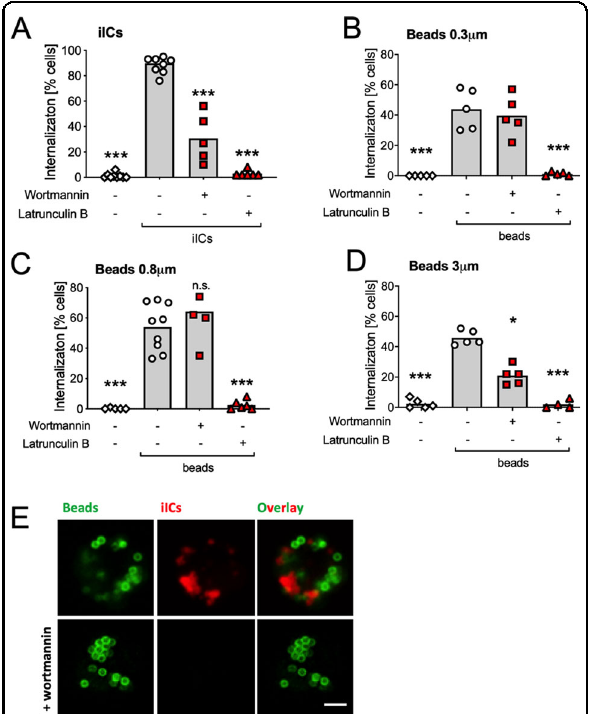
Fig. 4 Internalization of iICs and beads is controlled by distinct pathways. Neutrophils were incubated with small molecule inhibitors or vehicle at 37 °C for 10 min as indicated to inhibit PI3Ks and actin polymerization, respectively, and stimulated by mixing with A 2 μ g/ml iICs, B – D 5 IgG-opsonized beads/neutrophil of the indicated size or E a mixture of the iIC and 0.8 μ m beads for a further 30 min. Neutrophils were then allowed to adhere to electrostatically charged glass slides on ice and fi xed. Internalized and external iICs were labelled as detailed in ‘ Materials and methods ’ . A – D The percentage of cells that had internalized particles was counted and plotted. Each symbol represents the average value obtained in a separate experiment. Raw data were analyzed by one-way ANOVA and multiple comparison post-hoc test; *** p < 0.001; * p < 0.05. E Representative confocal images taken with a Leica SP8 with 63× oil immersion objective of neutrophils that had or had not been pre-incubated with wortmannin prior to being simultaneously stimulated with pre-labelled beads (green) and iICs (red). Scale bar, 2 μ m.